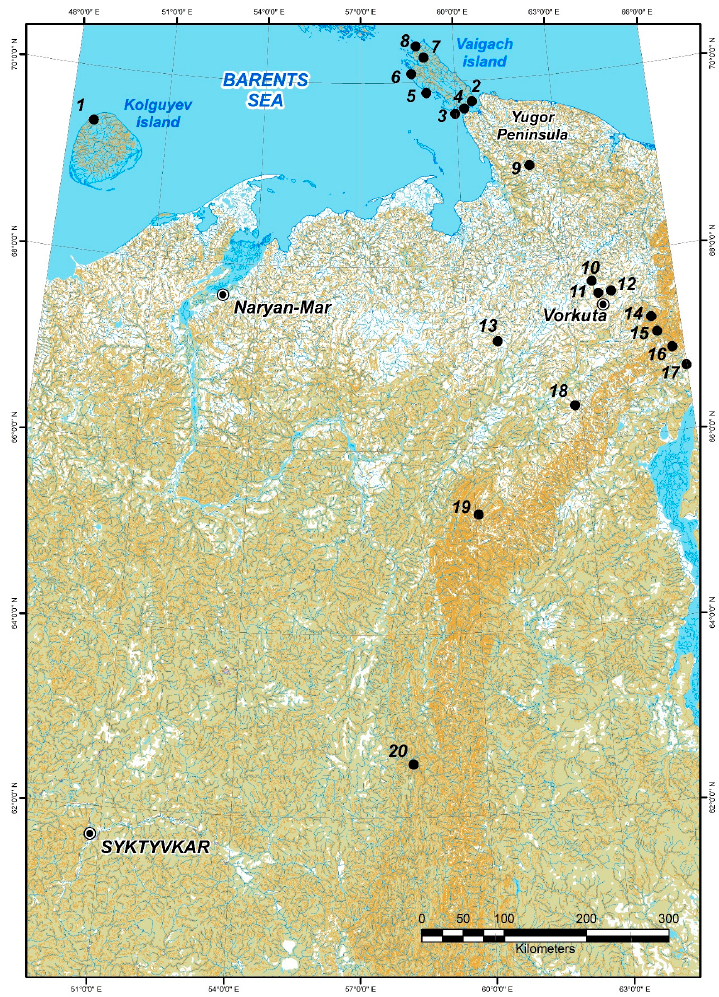
Figure A1. Localities within the region under consideration (see Table 1 for explanations). 1 – Kolguev Island (Krivolutsky et al., 2003), 2 – Vaigach Island, Yugorskiy Shar (Koch, 1879), 3 – Vaigach Island, Cape Greben’ (Koch, 1879), 4 – Vaigach Island (Trägårdh, 1904), 5 and 6 – Vaigach Island (Krivolutsky et al., 2003), 7 – Vaigach Island, Bolvansky mountain (Melekhina et al., 2019), 8 – Vaigach Island, Old Polar Station (Melekhina et al., 2019), 9 – Yugor Peninsula, Pai-Khoi Ridge (Melekhina and Zinovyeva, 2012), 10 – Bolshezemelskaya tundra, Vorgashor village (Melekhina, 1997), 11 – Bolshezemelskaya